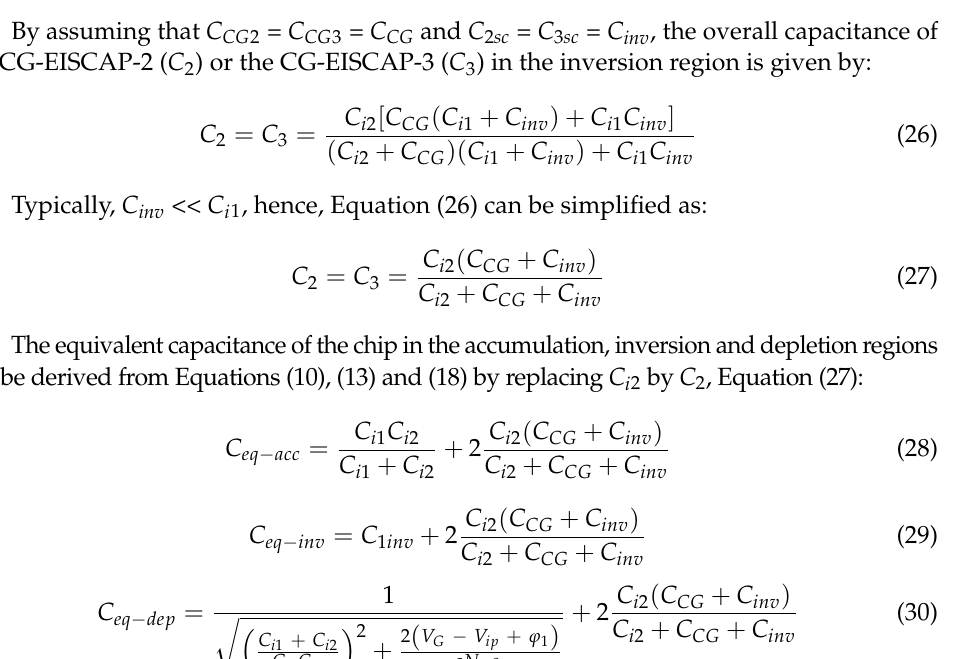
Figure 6. Equivalent circuit and measurement setup of the chip with a floating/capacitively-coupled CG setup. V CG 2 and V CG 3 : voltage applied to CG2 and CG3, respectively; V FG 2 and V FG 3 : voltage on the floating gate FG2 and FG3, respectively; C CG 2 and C CG 3 : control-gate capacitances; CC-CG2 and CC- CG3: capacitively-coupled control gate of CG-EISCAP-2 and CG-EISCAP-3, respectively.